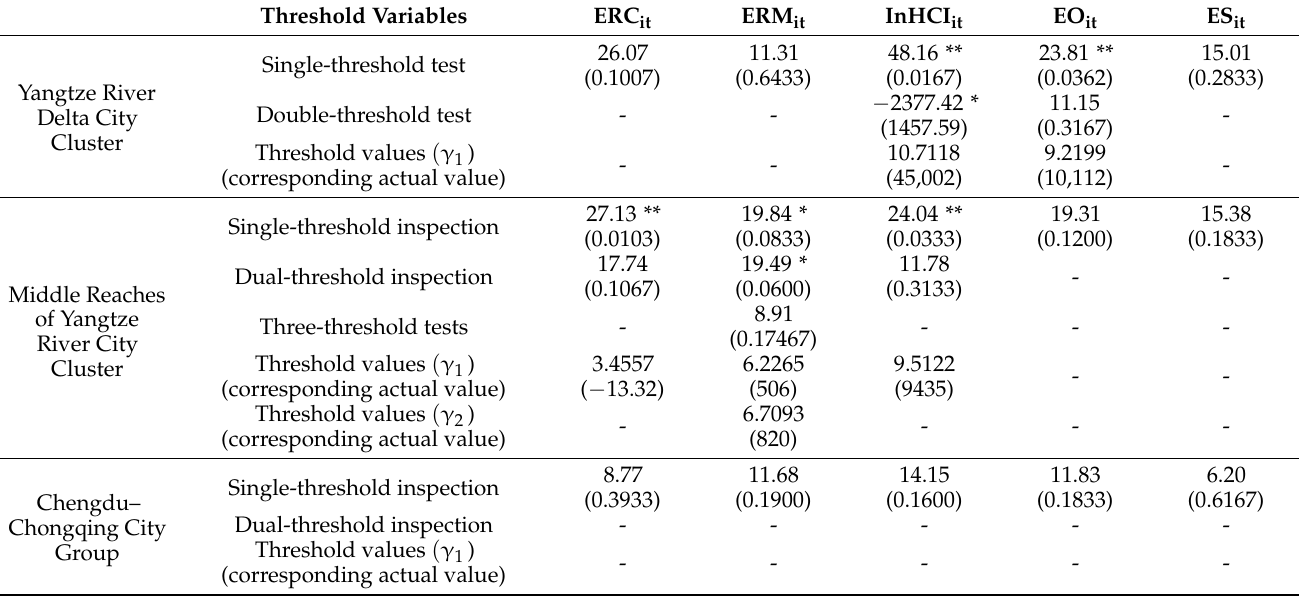
Table 7. Regression results of environmental regulation on ecological